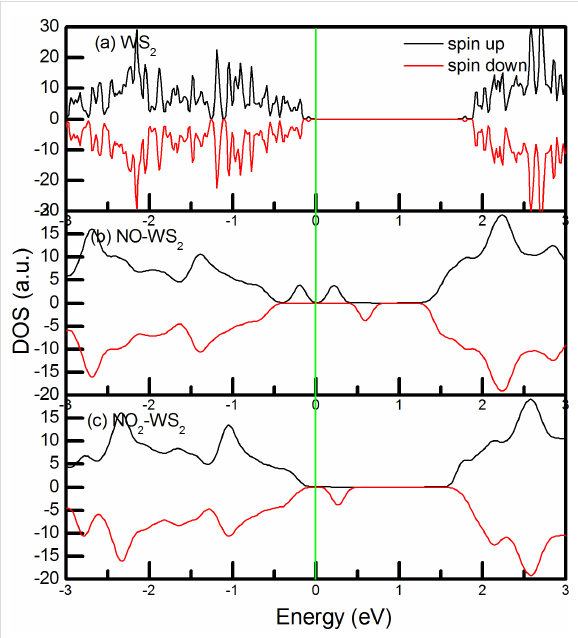
Figure 4: TDOS of (a) the pristine WS 2 monolayer, and the WS 2 monolayer with (b) NO adsorbed and (c) NO 2 adsorbed in humid envi- ronment. The Fermi level is indicated by the vertical green